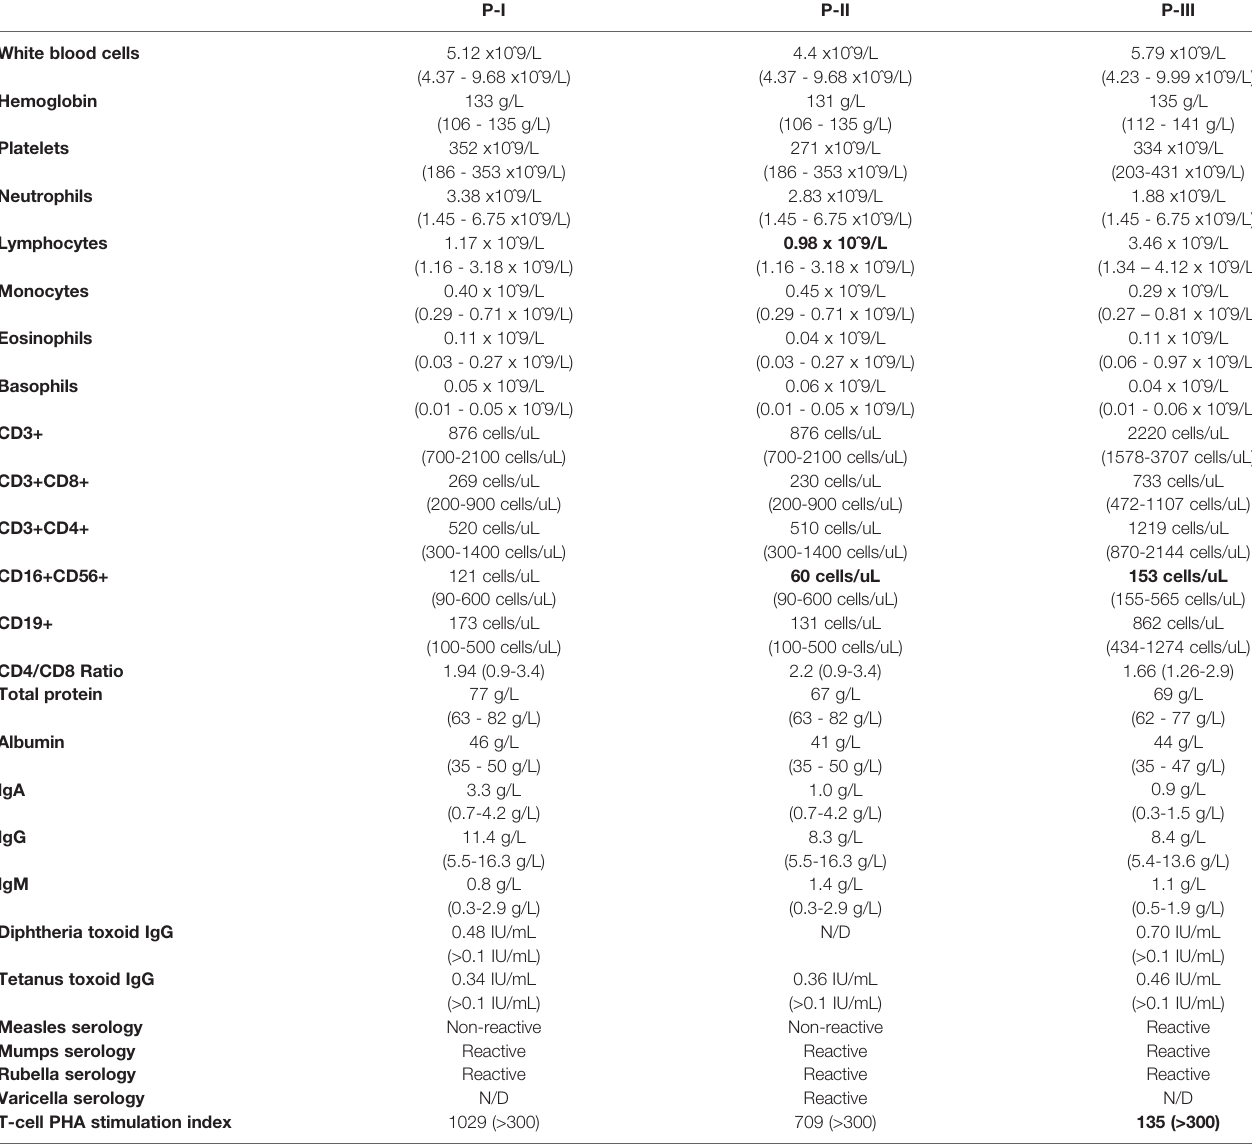
N/D, not done. Bolded values are outside of normal reference